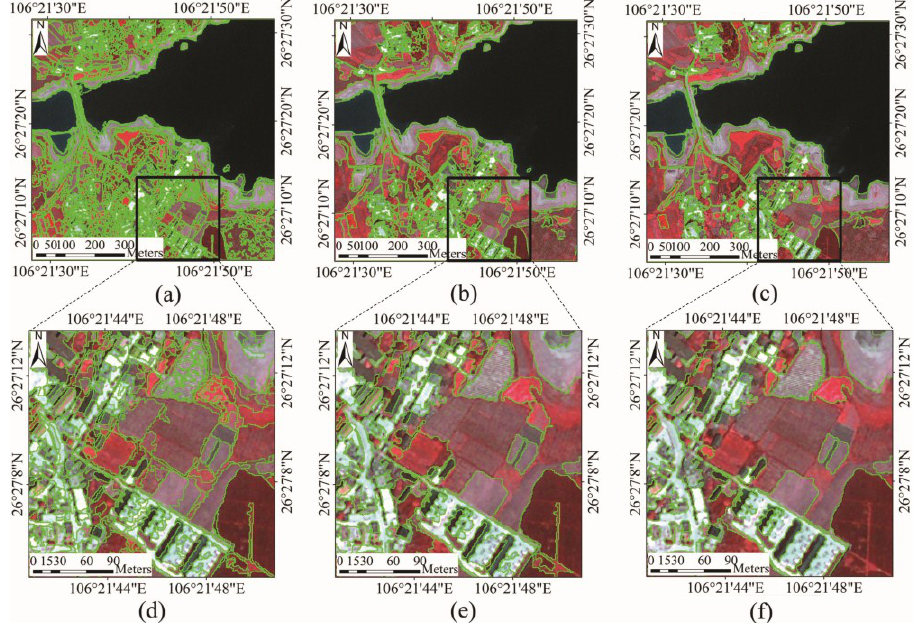
Figure 10. The influence of different MC values. All three tests set initial scale to 20, T to 300, and ε to 0.1. Only MC varied and was set to 30, 130 and 200 in ( a – c ), respectively. Images ( d – f ) are zoomed-in areas of (a–c),